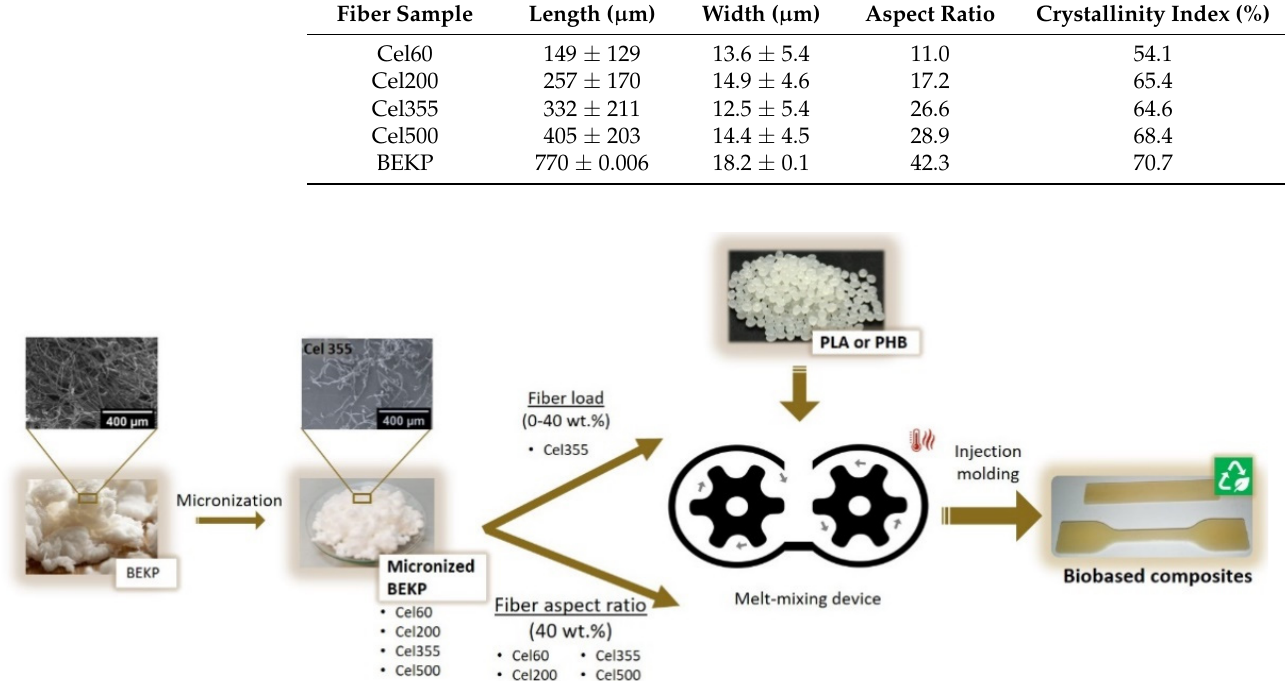
thermoplastic matrices. To study the effect of the aspect ratio of the fibers, four micronized fibers with distinct aspect ratios and BEKP (Table 1) were also melt-mixed with all four thermoplastic matrices for a fixed fiber load of 40 wt.% (Figure 1). Table 1. Average dimensions and crystallinity indexes of the cellulose fibers used in this study. Fiber Sample Length ( µ m) Width ( µ m) Aspect Ratio